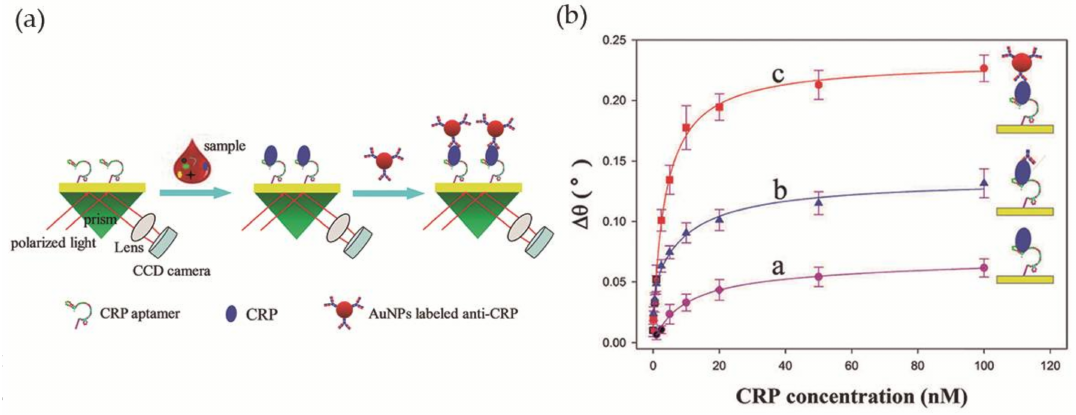
Figure 9. ( a ) Scheme of the biosensor operating with antibody-aptamer sandwich assay; ( b ) Variation of the refractive index with CRP concentration using direct, aptamer-antibody sandwich and Au NP-enhanced aptamer-antibody sandwich measurements. Reproduced with permission from ref.